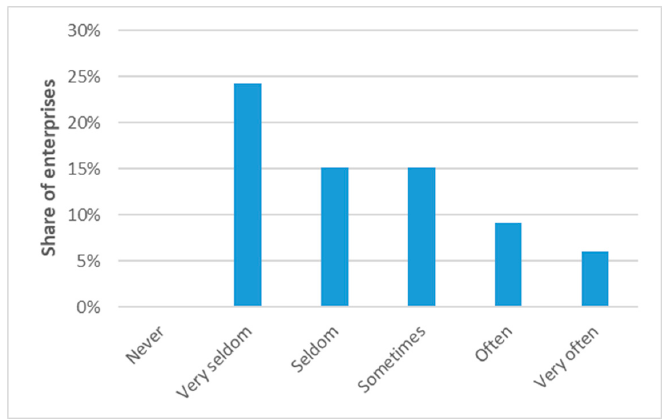
Figure 6. Procurement of new technologies.